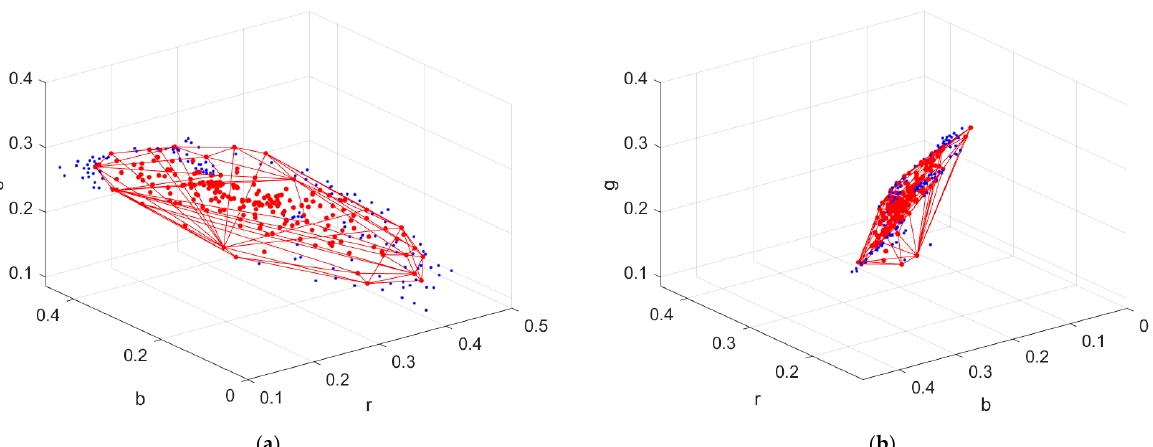
Figure 4. ( a ) Color points of the reference samples, inside samples, and outside samples in the rgb normalized signal space with red, green, and blue dots, respectively, where the camera is the RGBF camera. ( b ) The same as ( a ) except for viewing angle.